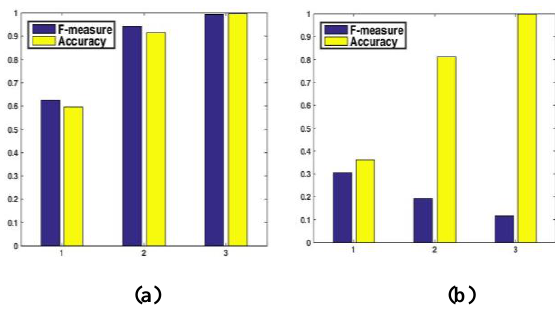
Figure 10. a) The accuracy and F-measure for aggregation dataset are near to one after running the three levels of the algorithm. b) Accuracy for the spiral dataset reaches one after running the three levels of the algorithm but the F- measure is low due to the large number of produced clusters.